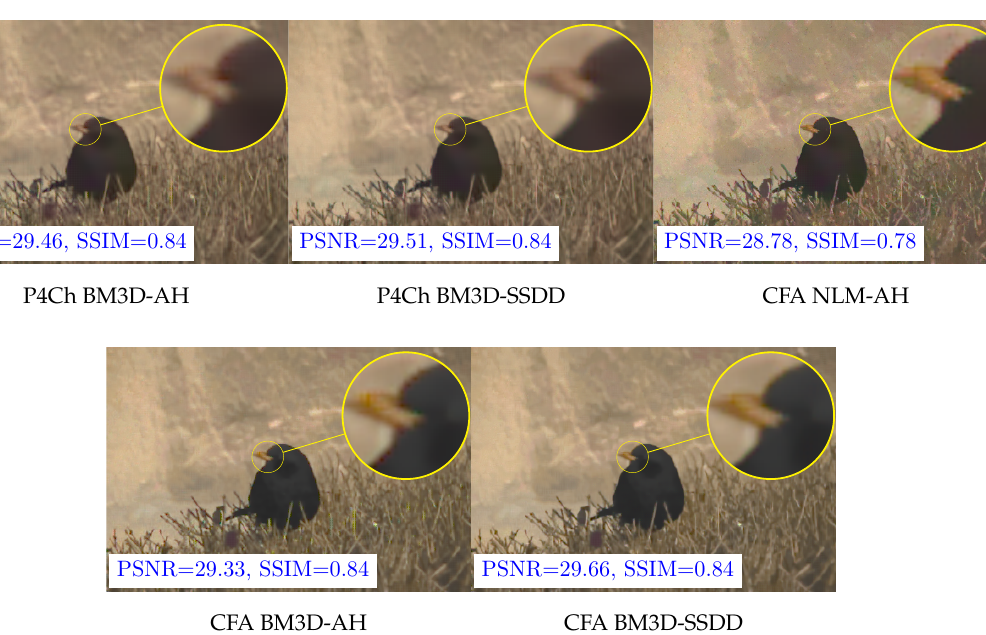
Figure 17. Filtering results for bird test image—ISO